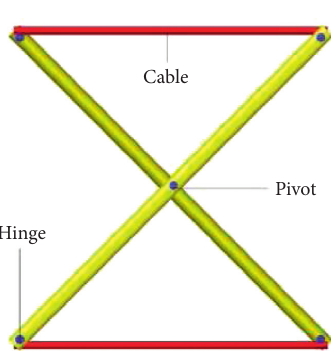
Figure 3: Planar element.